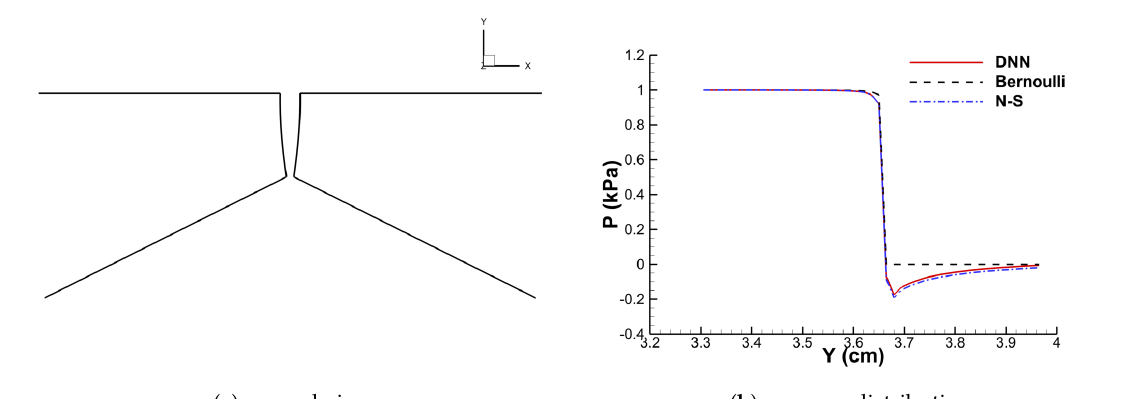
Figure 18. Convergent shape.